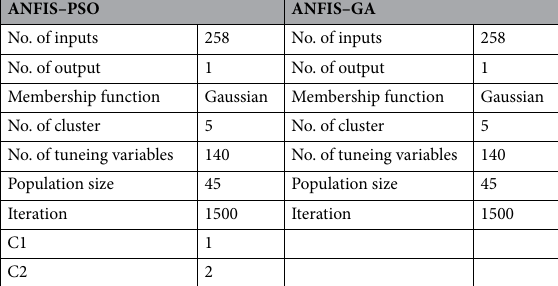
Table 1. Detail information of optimized ANFIS